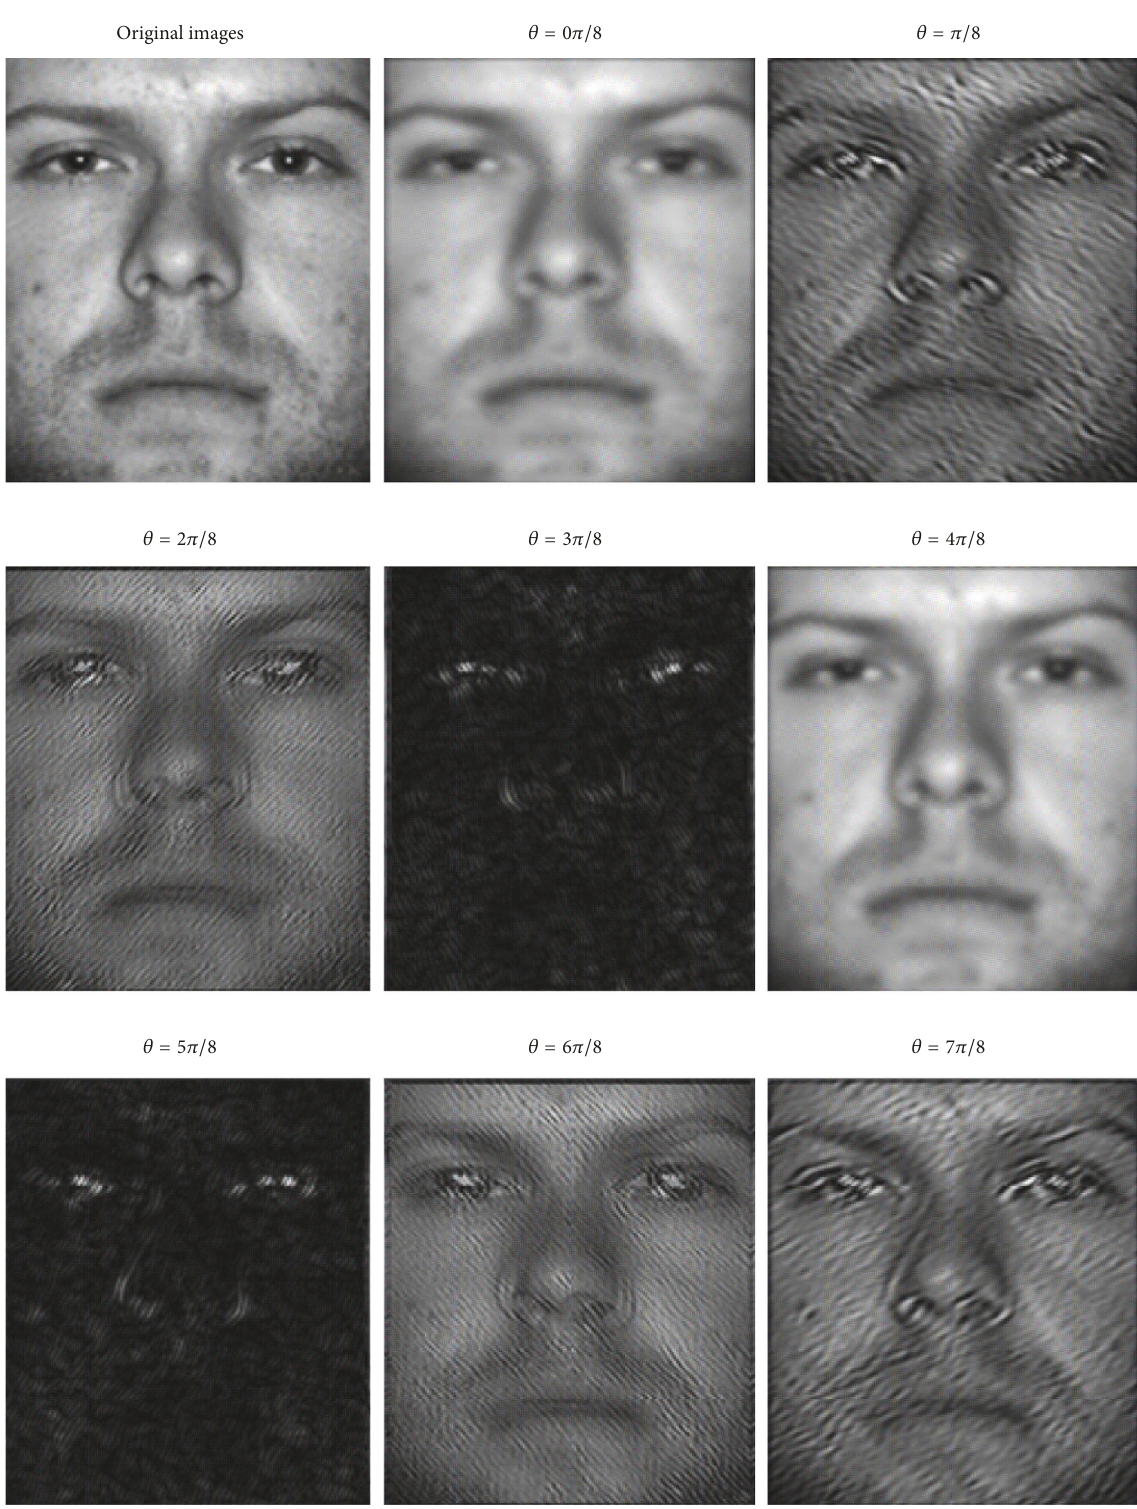
Figure 1: The Gabor spectrogram of a face